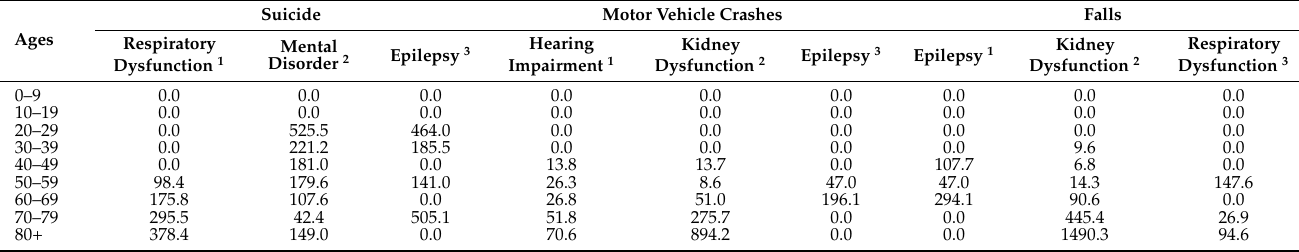
Table 4. Crude mortality rate due to the top three external causes of injury (ECIs) by age (unit: per 100,000 people).